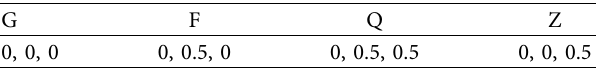
Figure 3: The reduced Brillouin zone for anatase TiO G point is the origin of coordinate. Table 1: Coordinates of high symmetry points within the first Brillouin zone for anatase TiO 2 .